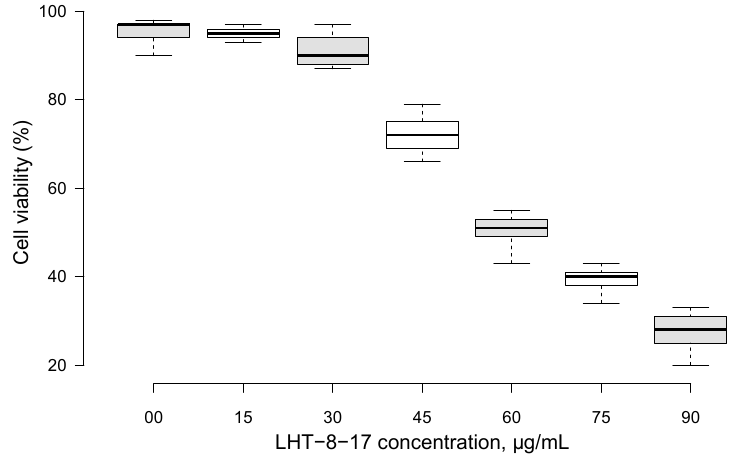
Figure 1. Metabolic activity of skin epidermal cells exposed to different concentrations of cerium- containing N-acethyl-6-aminohexanoic acid compound (LHT-8-17) in MTT assay. Data presented as a percentage of the cell viability in the control, median ± SD.